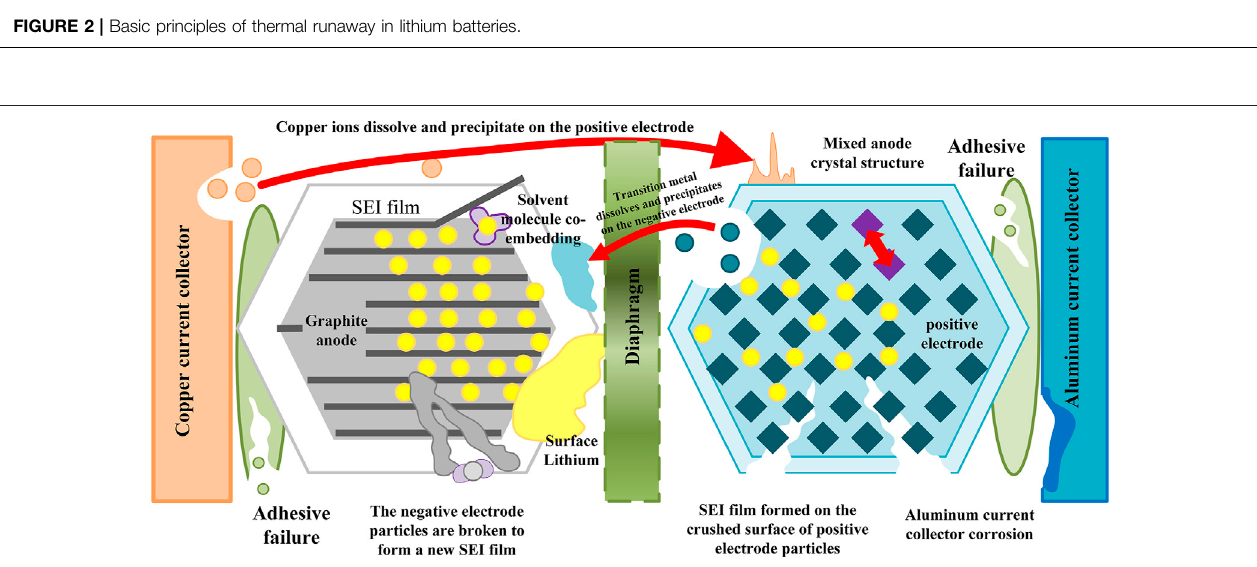
FIGURE 3 | Li-ion battery ageing decay